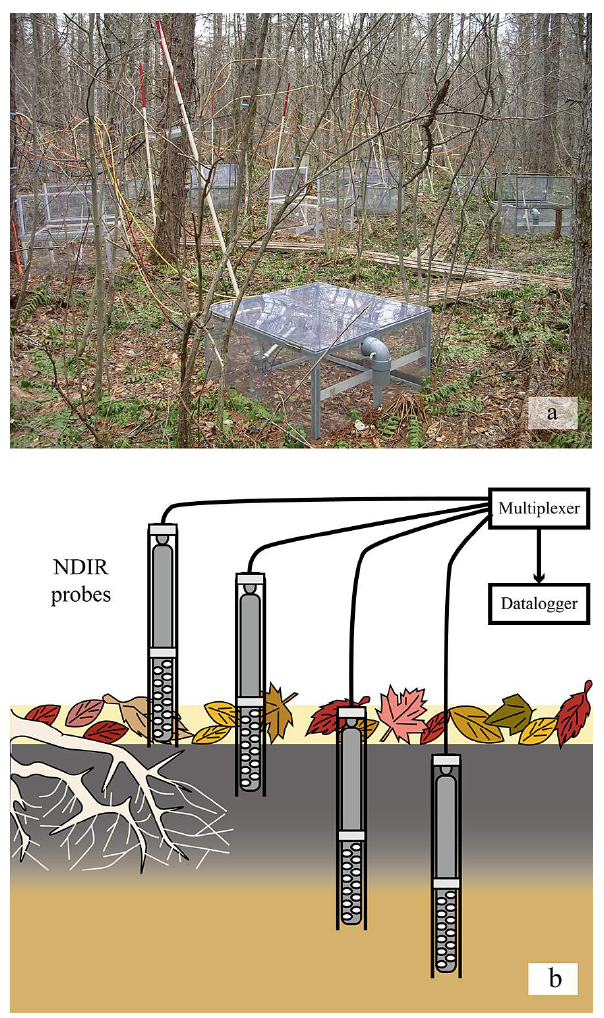
Fig. 2. Fig. 2. (a) Image of the multi-channel automated chamber